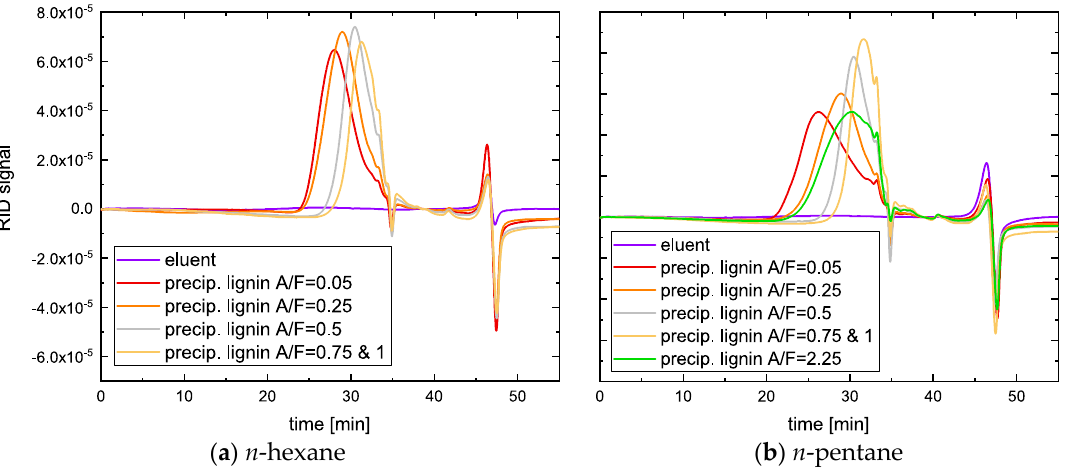
Figure 3. SEC chromatograms for 10 wt% OCL after consecutive precipitation using different antisolvent/feed volume ratios (A/F = 0.05–1) of ( a ) n -hexane and ( b ) n -pentane. In the case of n -pentane as the antisolvent, the A/F = 2.25 was precipitated in a separate experiment from a 10 wt% OCL solution.